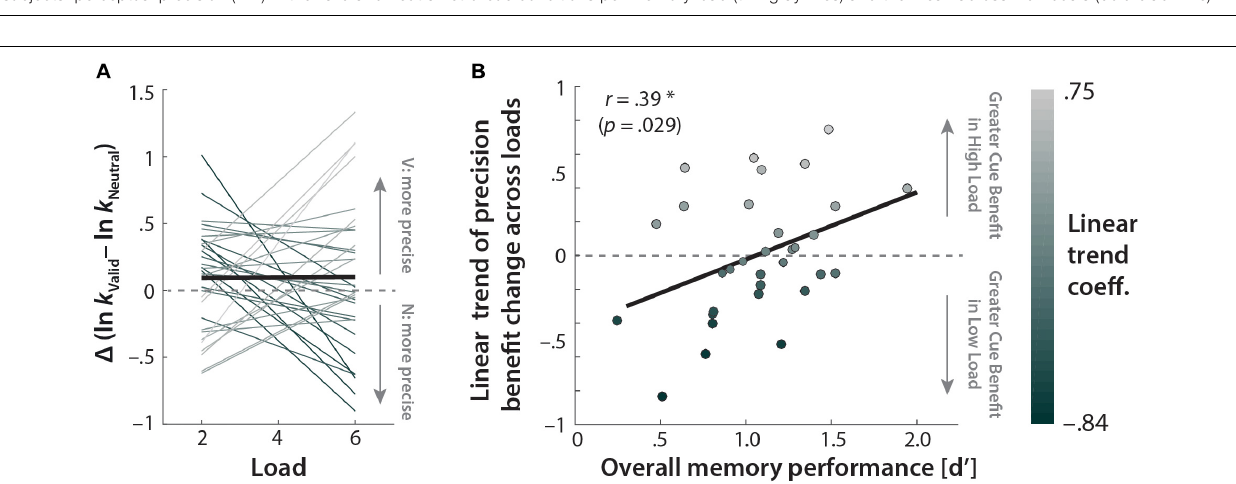
FIGURE 5 | Inter-individual differences in perceptual precision benefits from valid vs. neutral retro-cues in each memory load condition. (A) Psychophysical modeling results of two individuals exhibiting different trends of precision benefits from valid retro-cues. In each memory load condition, psychophysical model parameters are separately estimated for the valid and neutral retro-cue conditions. (Top) An individual exhibiting a decrease in cue-related precision benefit as memory load increases (i.e., blue slope becomes shallower with higher memory load). (Middle) An individual exhibiting the reverse pattern; an increase in cue benefits as memory load increases. (Bottom) The change of cue-related precision benefits (ln k Valid –ln k Neutral ) of the two individuals exhibiting an opposite pattern across loads. (B) Individual subjects’ perceptual precision (ln k ) in the valid and neutral retro-cue conditions per memory load (thin gray lines) and the mean across individuals (bold black line).